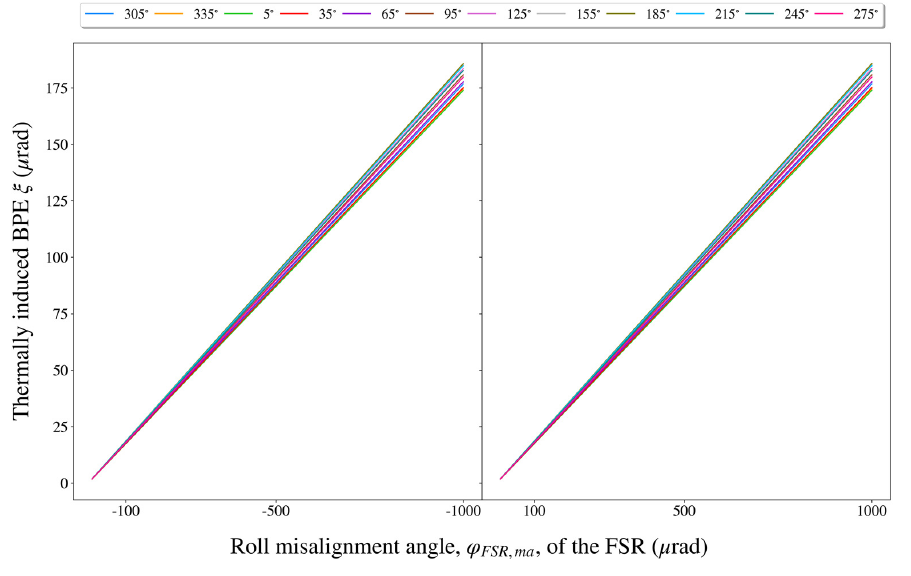
Figure 6. The impact of the roll misalignment angle ϕ FSR, ma of the FSR on the BPE. ( a ) The variation of the BPE with respect to the ECF scan azimuth at some fixed levels of ϕ FSR, ma . ( b ) The variation of the BPE with respect to ϕ FSR, ma at some fixed ECF scan